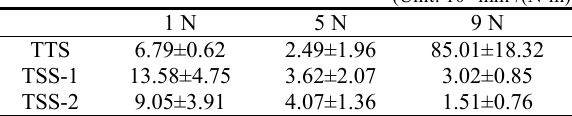
Table 3 Wear rate of corresponding SUS304 balls tested along different directions under different